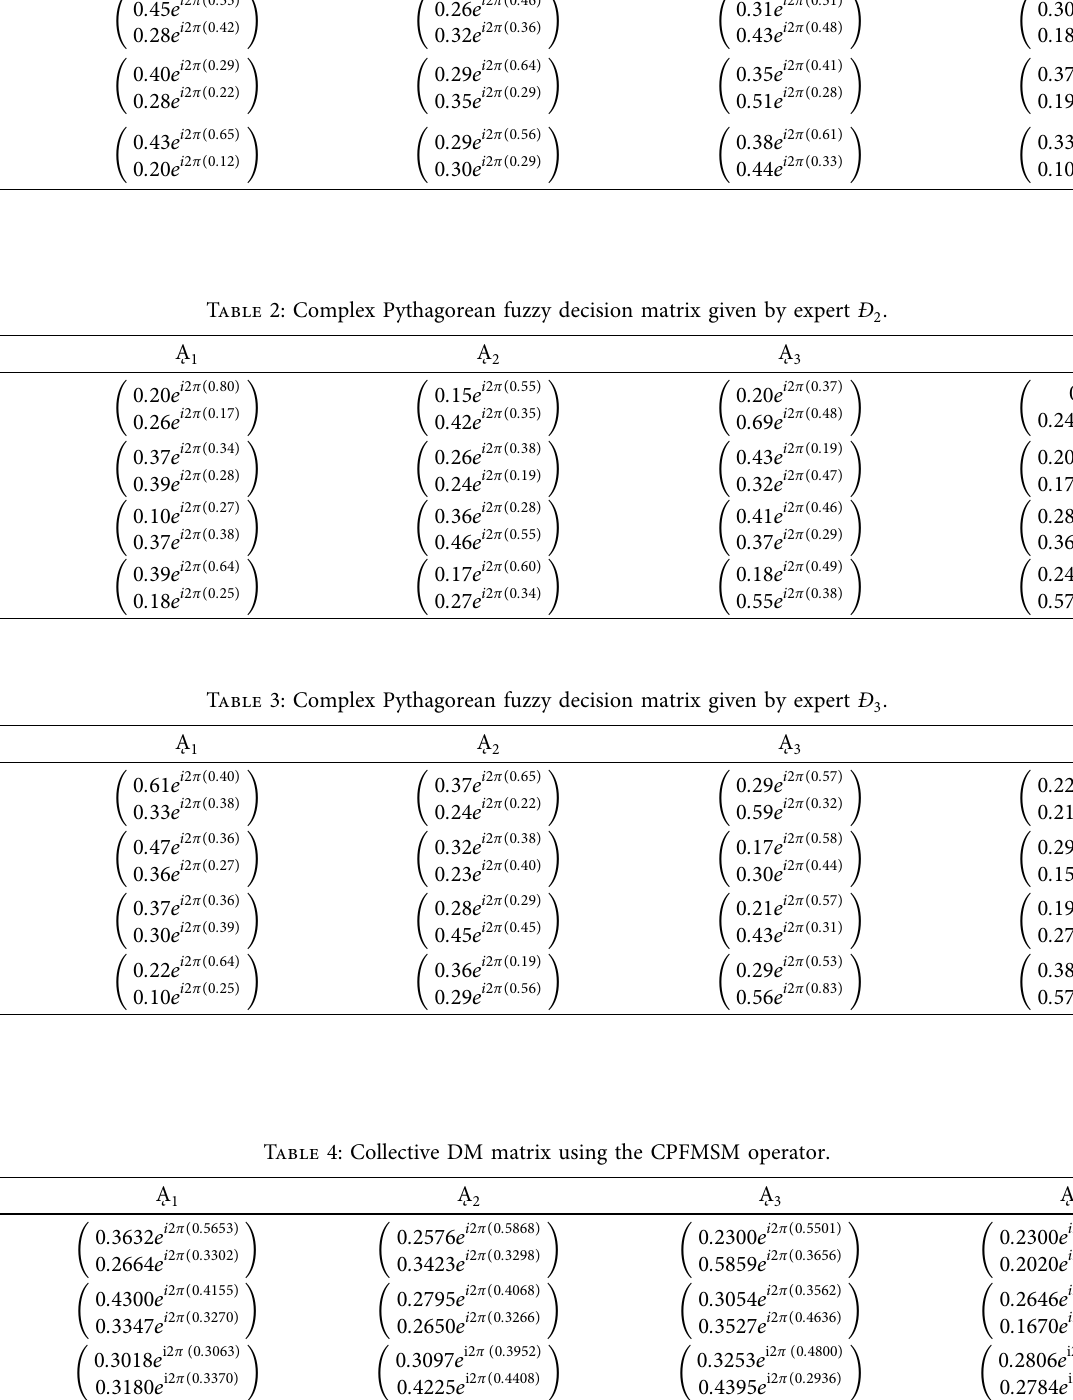
Table 1: Complex Pythagorean fuzzy decision matrix given by expert Đ